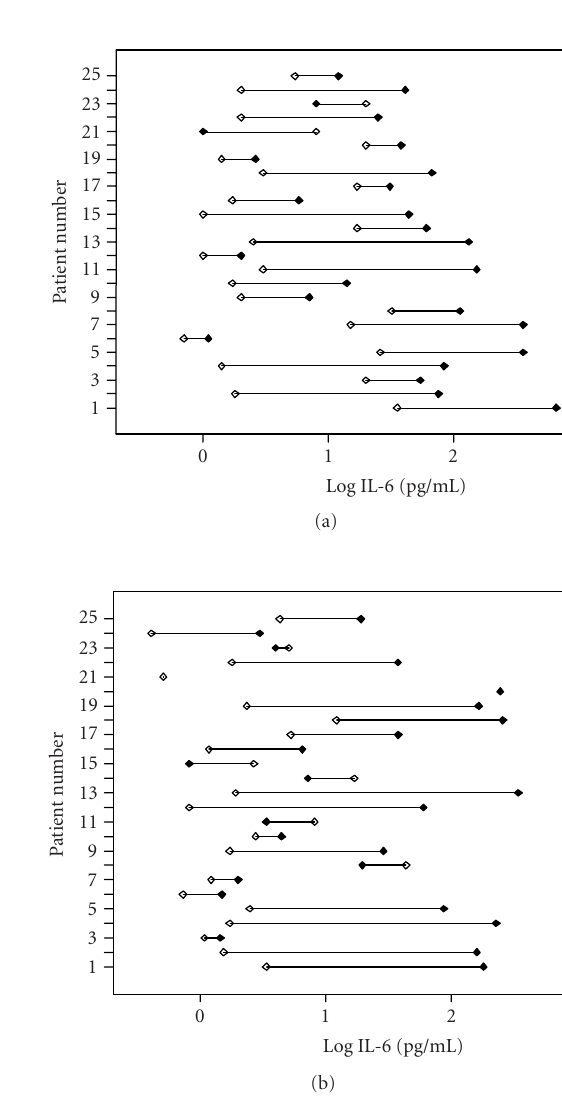
Figure 1. Individually plotted values of TNF- α (logarithmic scale) in involved (closed symbols) and uninvolved sides (open symbols) of all CRPS 1 patients, (a) at first measurement (T0) and (b) at follow-up measurement (Tf). Note that on T0 (acute stage), 19 patients displayed an increased value in the involved versus the uninvolved extremity, whereas on Tf (intermediate stage), still 16 patients displayed an increased value.